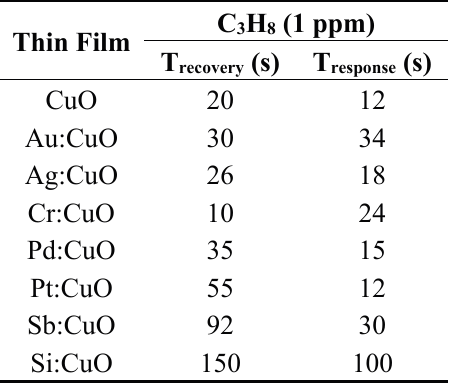
Figure 15. Response and recovery step of the resistance of the CuO-, Au:CuO and Cr:CuO-based sensors toward 1 ppm C 3 H 8 at 50% RH and 250 °C. Table 3. The response and recovery time (s) obtained for 50-nm films deposited at 100 °C and annealed at 500 °C for 4 h in air under exposure to 1 ppm C 3 H 8 at the temperature with the maximum sensor response (see Figure